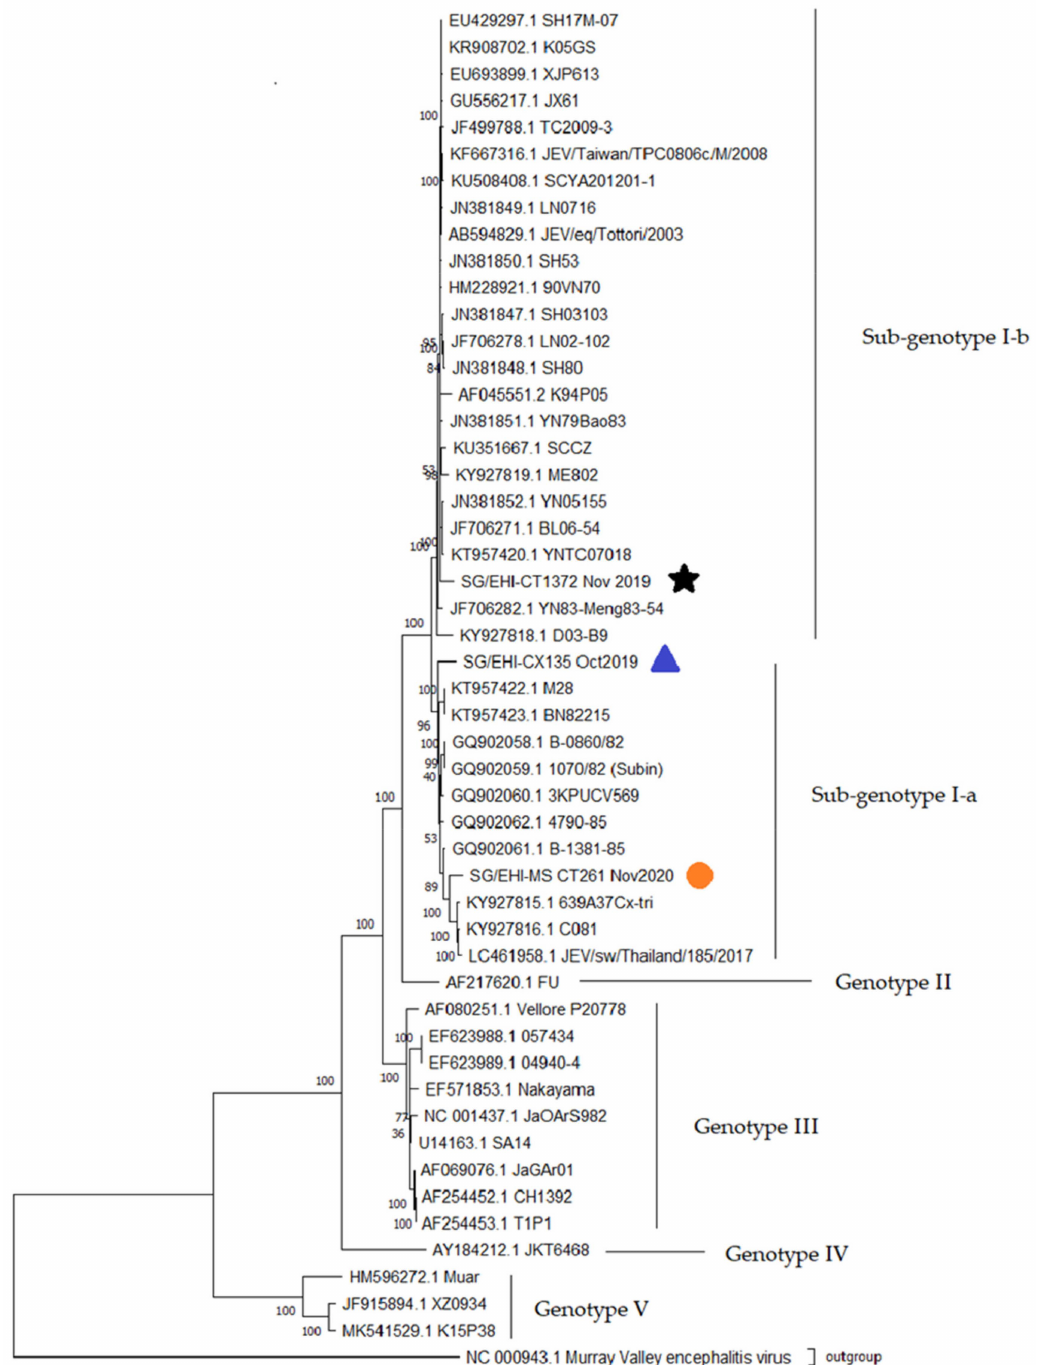
Figure 3. Maximum likelihood phylogenetic analysis of 50 JEV whole genome isolates. This tree was constructed using TN93+G+I with 1000 bootstrap iterations; the outgroup is MVEV (NCBI Reference Sequence no. NC_000943.1). The JEV isolates presented in this study are indicated with a star: SG/EHI-CT1372; blue triangle: SG/EHI-CX135; orange circle: SG/EHI-MS_CT261. The colors correspond to the clusters indicated in Figure 2. Genotypes are as indicated. Each node is labelled with the GenBank Accession No. (where available) followed by the isolate